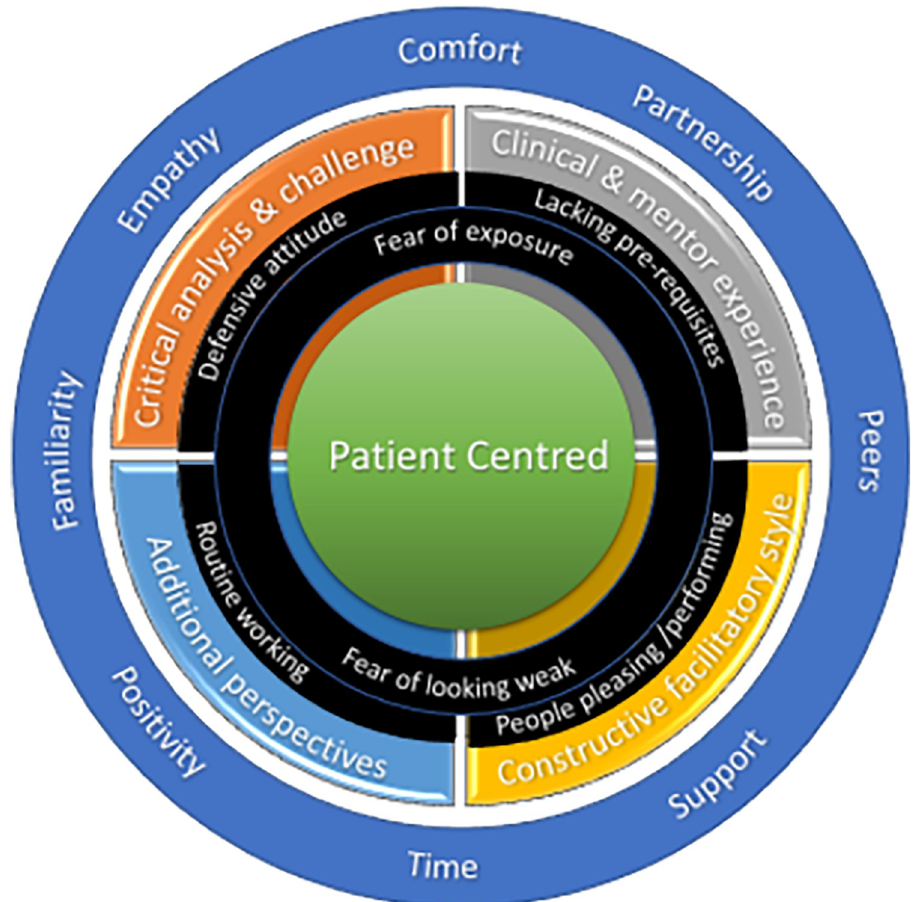
Fig 7. Mentor barriers to the emergent model of